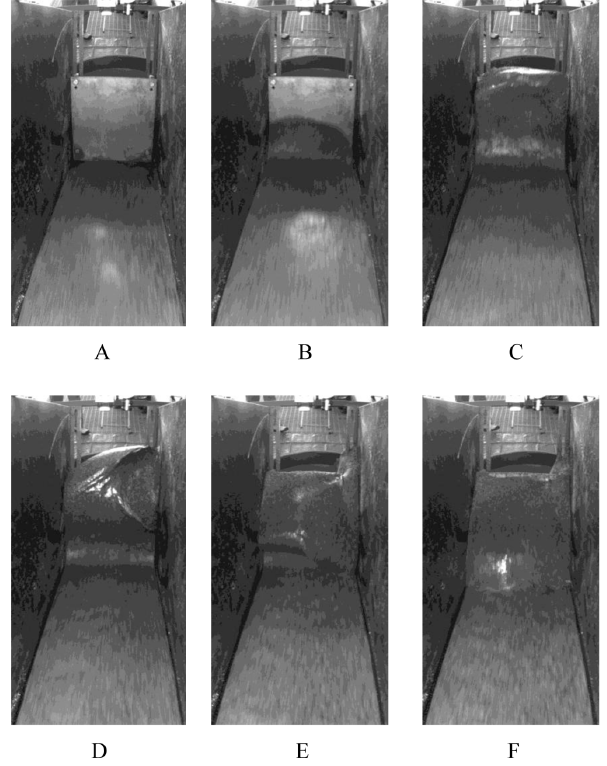
Fig. A2. Impact sequence, taken from Camera 2, for the rigid bar- rier vertically mounted (See Fig. 6). (A) debris flows at the onset of impact, (B) initial phase of the impact, (C) development of the ver- tical jet-like wave, (D) initial falling of the jet-like wave, (E) impact of the falling jet-like wave on the debris flow, (F) jet-like wave is completely fallen inside the